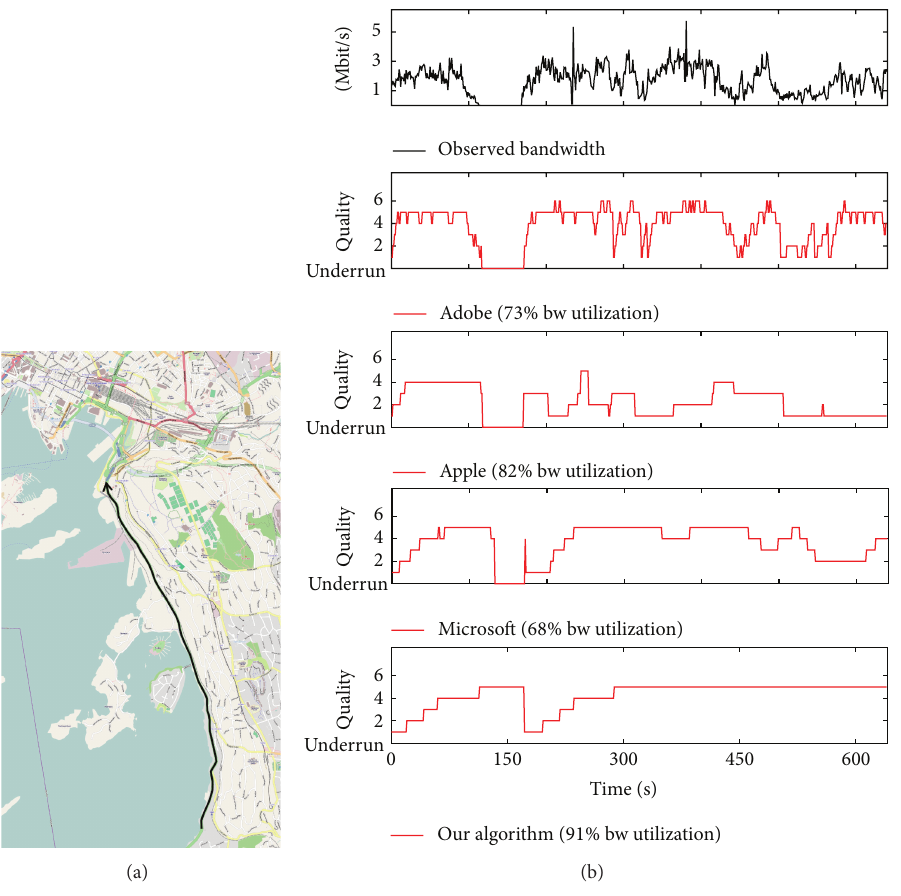
Figure 14: A comparison of quality adaptation algorithms in different media players. The map on the left shows the used bus route. For more examples, see [10].